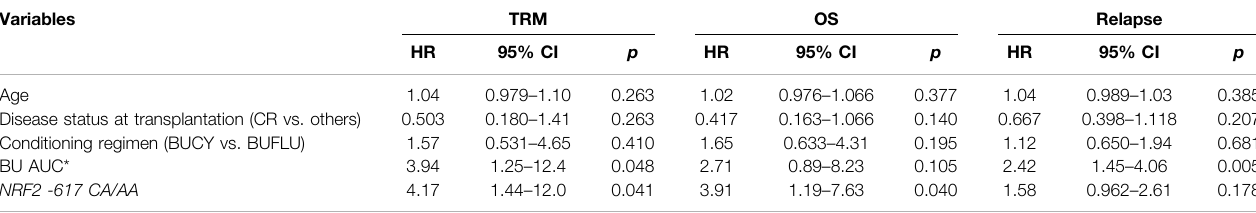
TABLE 3 | Multivariable analysis on TRM, OS, and relapse. Variables